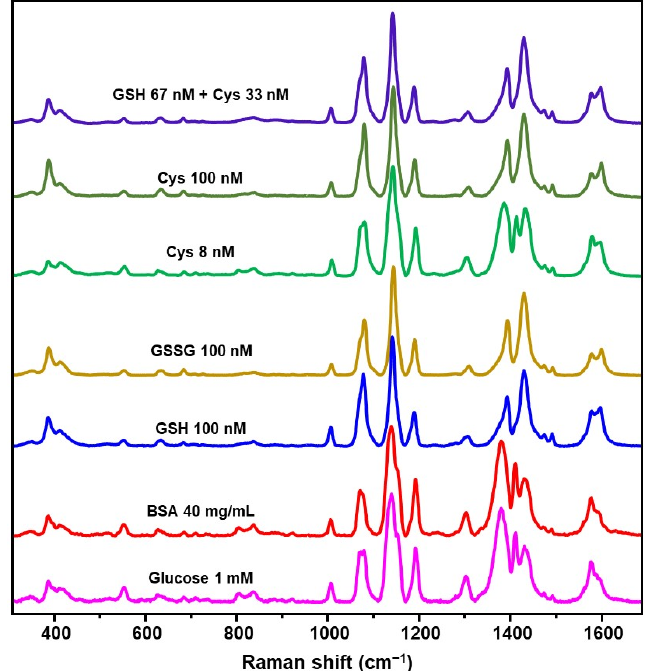
Figure 5. SERS spectra of Ag@AzoProbe@PEG clusters in PBS buffer (pH 7.4) containing glucose (1 mM), BSA (40 mg/mL), GSH 100 nM, glutathione disulfide (GSSG) 100 nM, cysteine (Cys) 8 and 100 nM, and a mixture of GSH+Cys (6.7 × 10 − 8 M and 3.3 × 10 − 8 M, respectively).